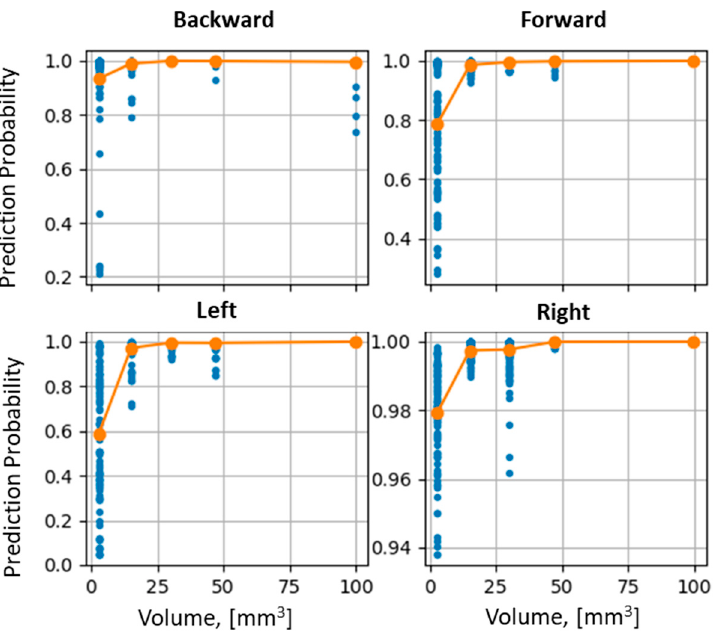
Figure 10. Probability of classification by SVM model with “mixing” dataset.